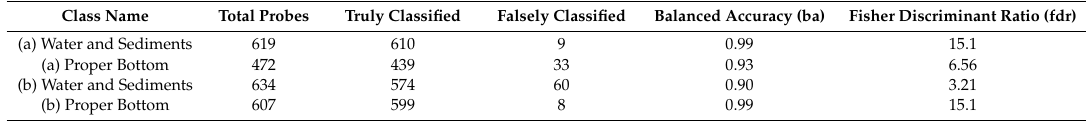
Table 2. CANUPO classification between water, sediments and proper bottom in two representative datasets from the Riegl VQ820G. Each scenario shows the results from (a) the first flight and (b) the second